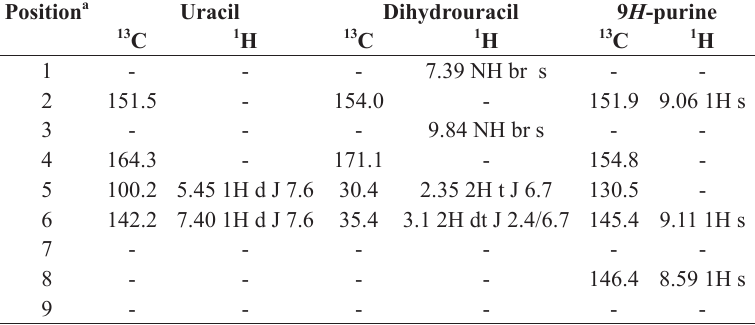
a See Figure 1. "–" Without absorption.